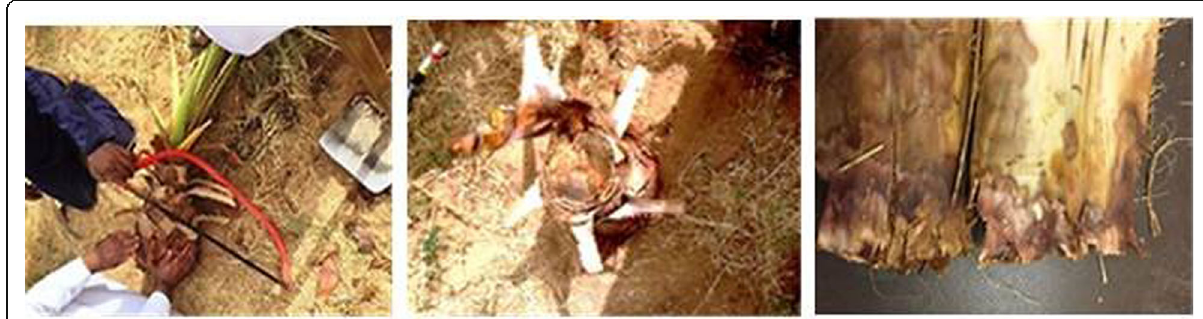
Fig. 2 The transverse section in the base of diseased Washingtonia robusta tree (left) showing discoloration and rot of the petiole bases and terminal bud (middle) and brown lesions covered partially with white mycelium (right)